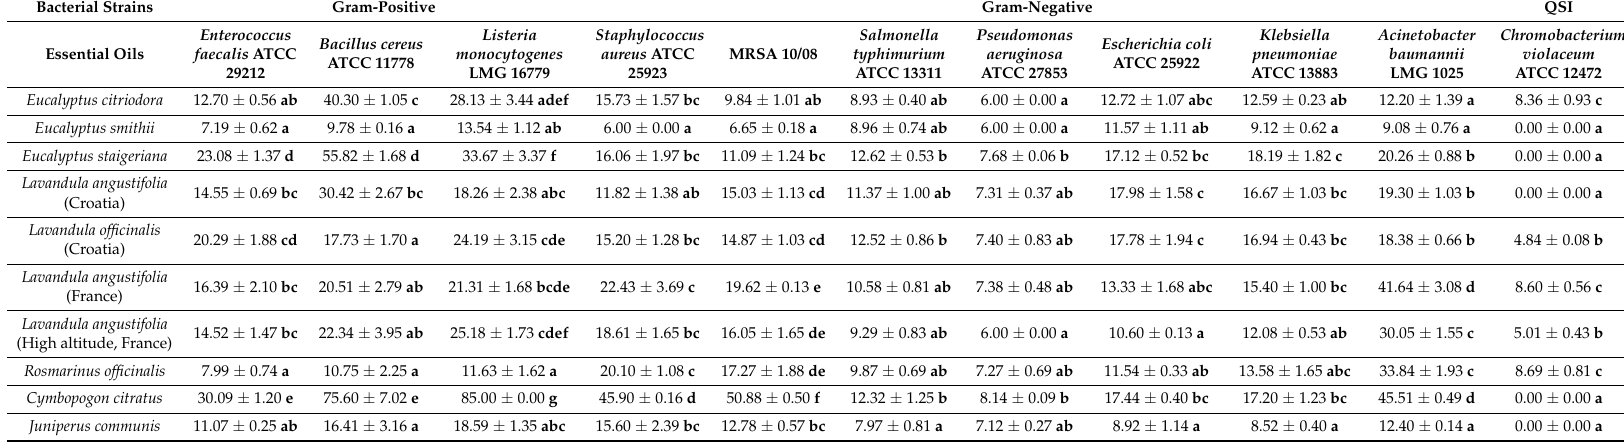
Table 6. Antibacterial and anti-quorum sensing properties evaluated as the diameter of inhibition zones (mm) of the EOs (10 µ L/disc). Bacterial Strains Gram-Positive QSI Essential